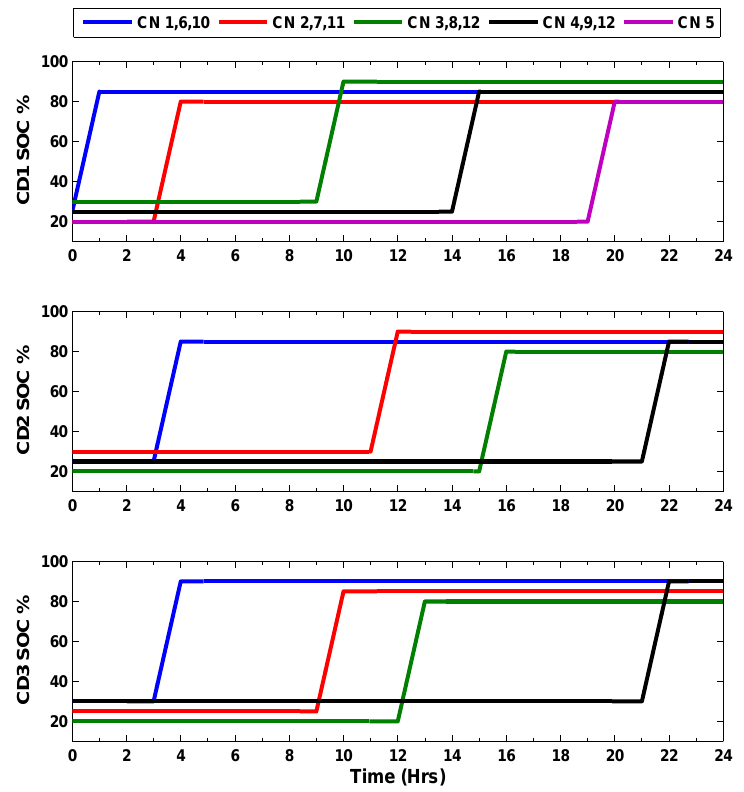
Figure 22. States of charge (SOCs) of different cars at different charging docks